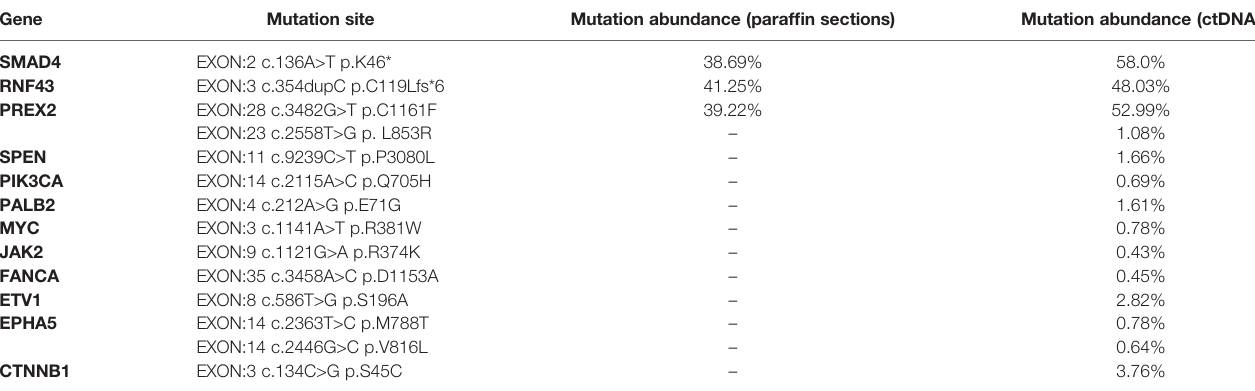
TABLE 1 | The results of sequence analyses of paraf fi n sections and ctDNA on December 1, 2020. Gene Mutation site Mutation abundance (paraf fi n sections) Mutation abundance